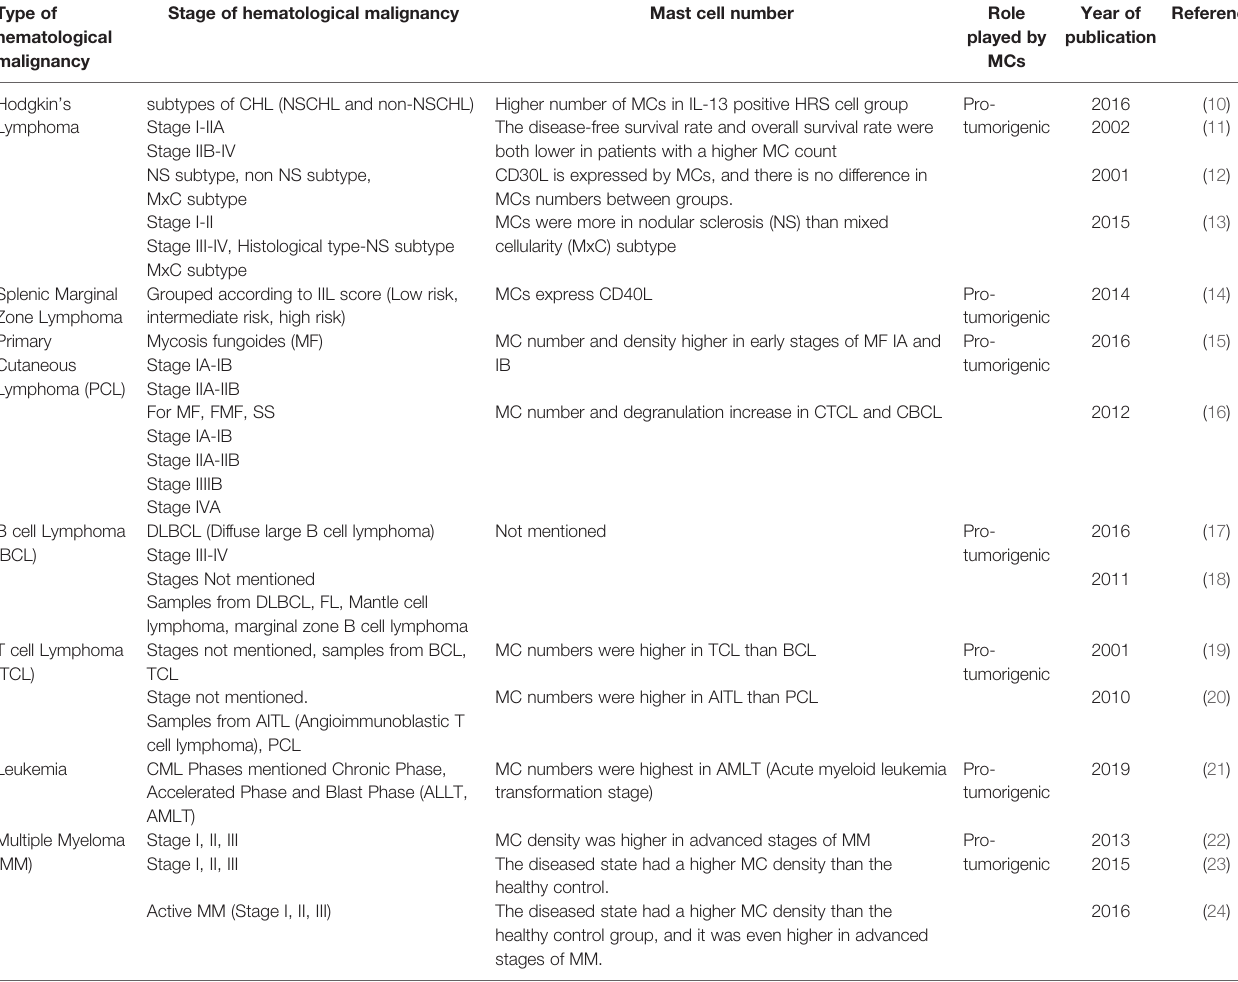
TABLE 1 | Characteristics of clinical studies included in this review mentioning the stage of hematological malignancies and number of mast